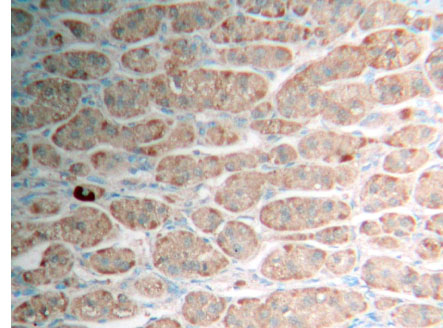
Adrenocortical adenoma FHIT (++) SuperisionTM two footworks